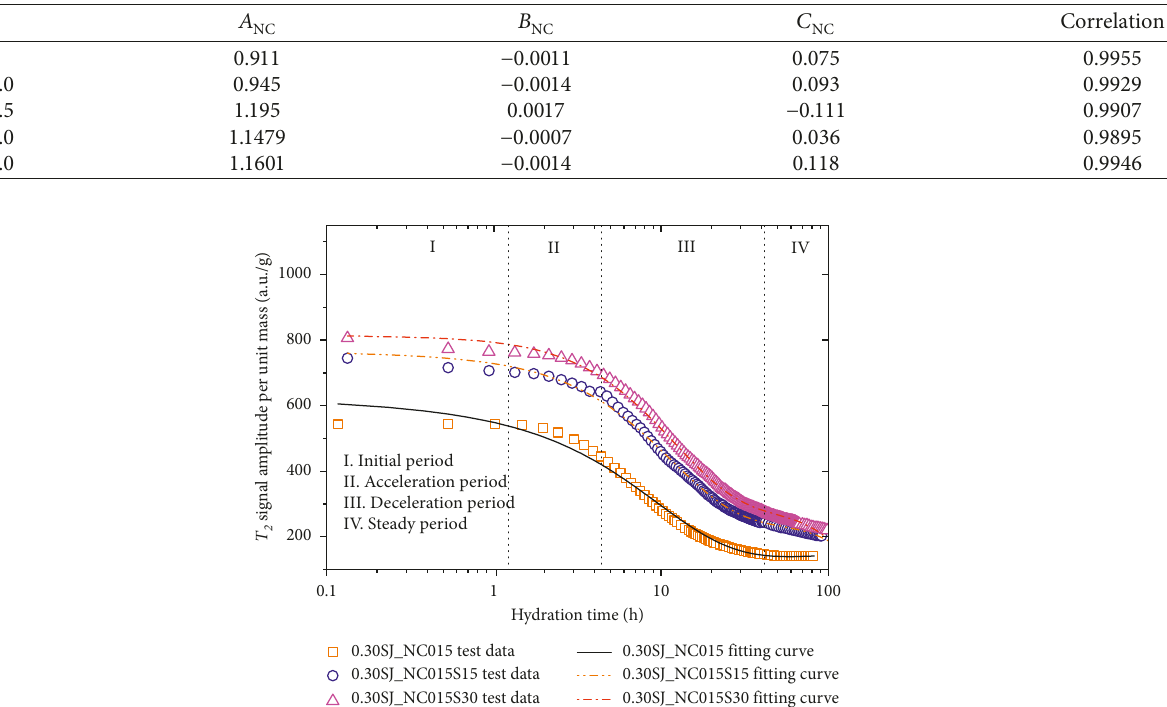
Table 8: Fitting parameters and correlation of cement pastes with different NC dosages.